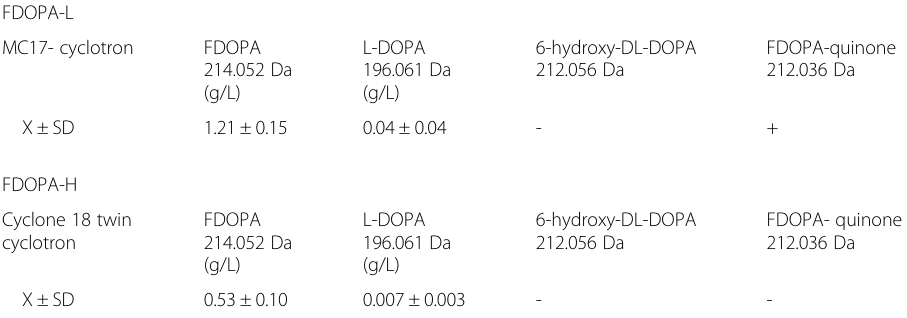
Table 2 Concentrations and identification of FDOPA and L-DOPA (g/l) and side products in FDOPA-L and FDOPA-H batches analyzed with UPLC-MS (both n =